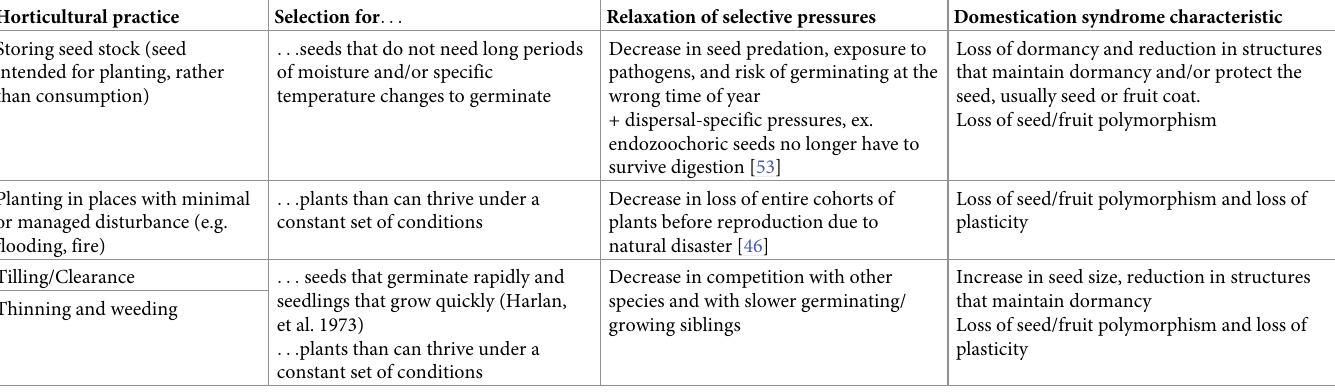
Table 1. Hypothetical selective pressures on annual plants associated with seed-saving and planting. Horticultural practice Selection for